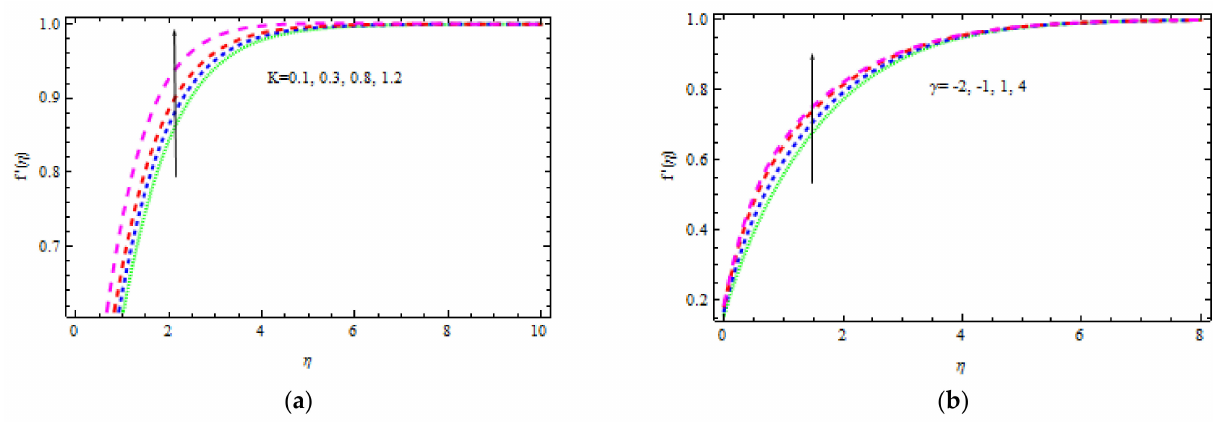
Figure 4. Inspiration of K ( a ) and γ ( b ) on